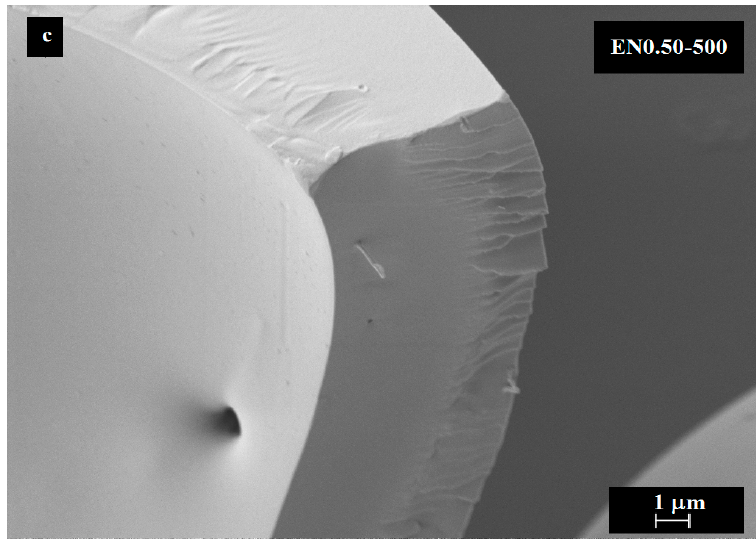
Figure 9. SEM micrographs showing interior surface and shell thickness of microcapsules containing epoxy/CNT mixtures prepared at: ( a ) 500 rpm with no CNTs, ( b ) 1000 rpm with no CNTs, and ( c ) 500 rpm with 0.5 wt % CNTs.